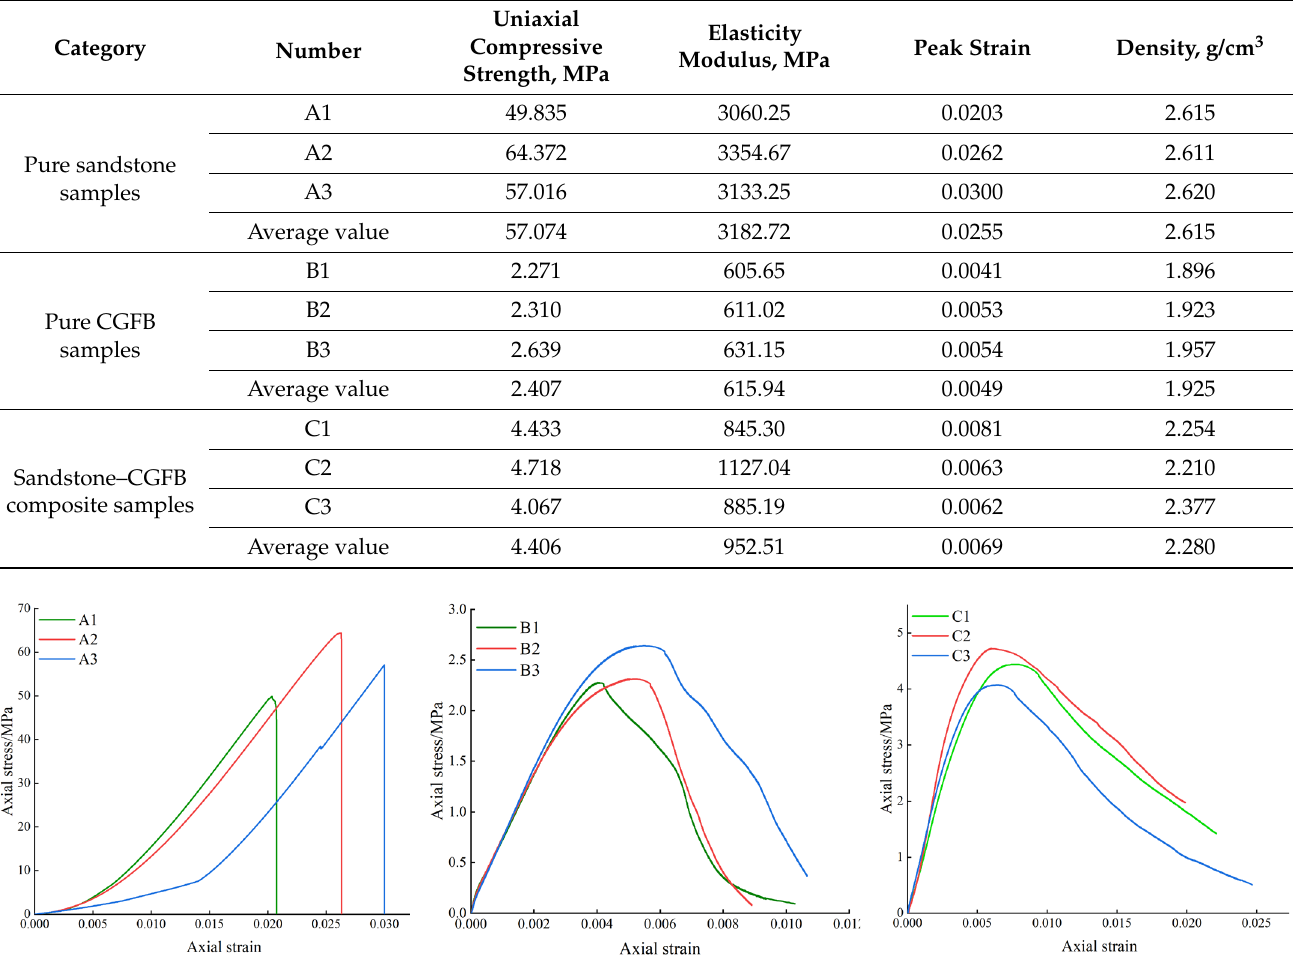
Table 1. Uniaxial compression experiment results of sandstone, CGFB, and sandstone–CGFB com- posite samples.